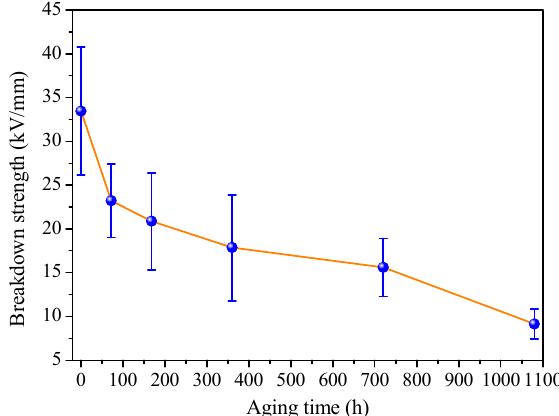
Figure 3. Breakdown strength of aged SiC/epoxy micro-composites.